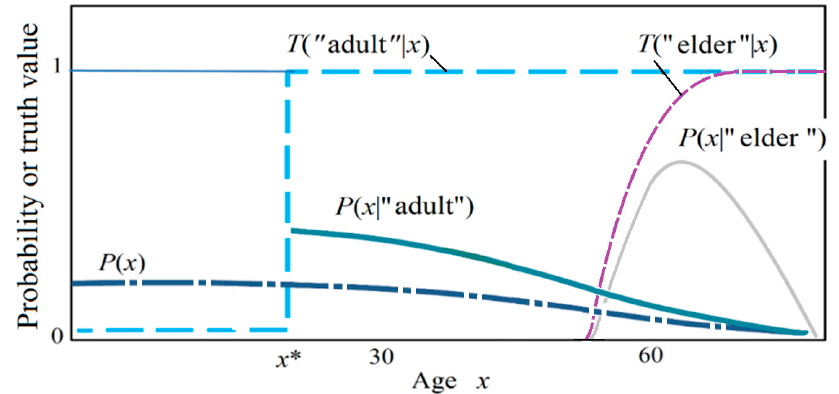
Figure 1. Solving the truth functions of “adult” and “elder” using prior and posterior probability distributions. The human brain can guess T (“adult” | x ) (cyan dashed line) or the extension of “adult” from P(x | ”adult”) (dark green line) and P(x ) (dark blue dashdotted line) and estimate T (“elder” | x ) (purple thin dashed line) or the extension of “elder” from P(x | ”elder”) (grey thin line) and P(x ). Equations (12) and (22) are new formulas for calculating T (“adult” | x ) and T (“elder” | x ).